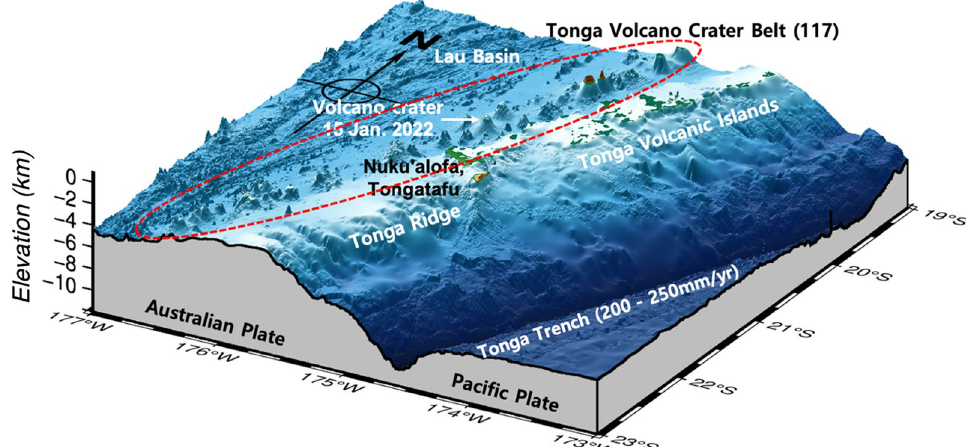
Fig. 3 Tonga volcano crater belt and subduction zone between the Australian and Pacific plates in this study